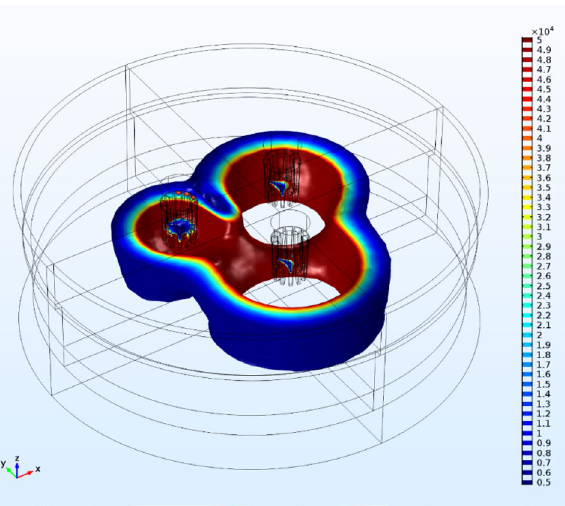
Figure 4. The reductive smelting in SAF is due to the Joule heat. The Joule heat isosurfaces (W/m 3 ) at the time